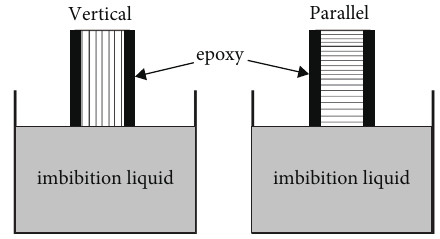
Figure 3: Bedding surface and bottom surface direction.